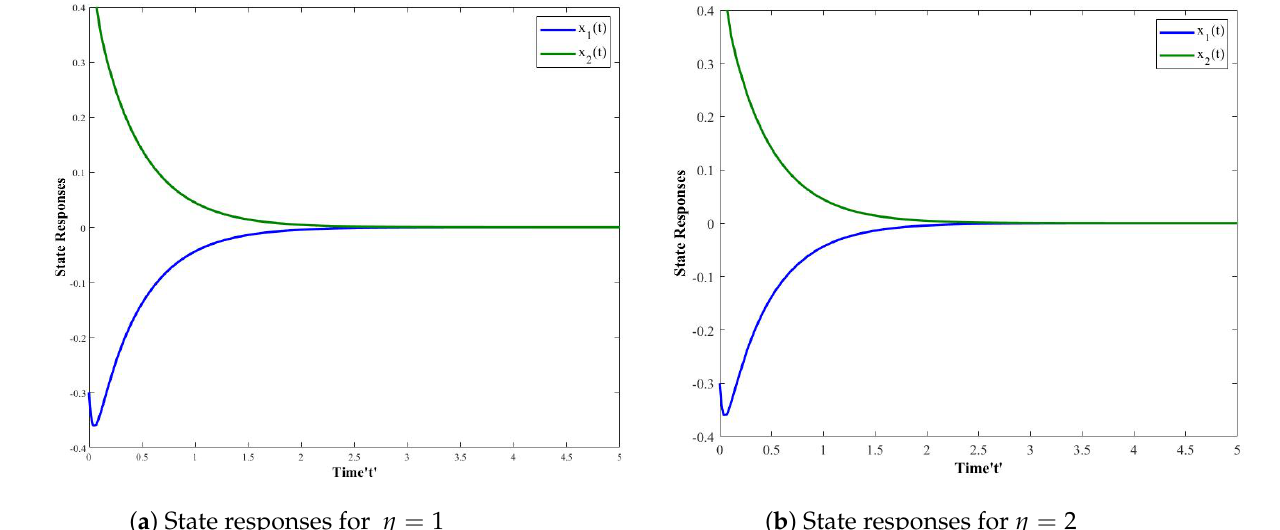
Figure 2. Simulation results for nonlinear uncertain TS fuzzy